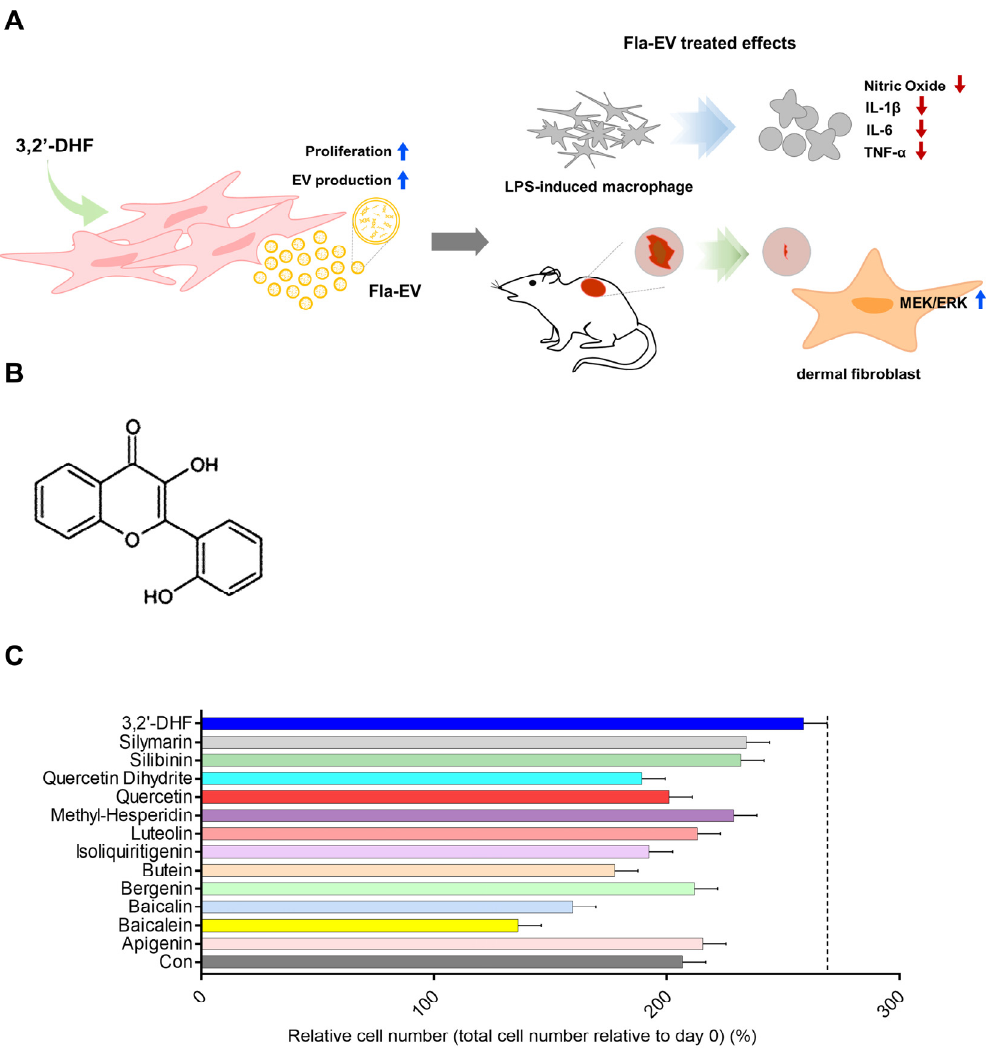
Figure 1. Structure of 3,2 (cid:48) -DHF and screening of several flavonoid treatments in WJ-MSCs. ( A ) Schematic illustration of therapeutic effects of Fla-EV. ( B ) Structure of 3,2 (cid:48) -dihydroxyflavone. ( C ) Comparison of time-dependent cell growth in several flavonoid treatment conditions derived from various